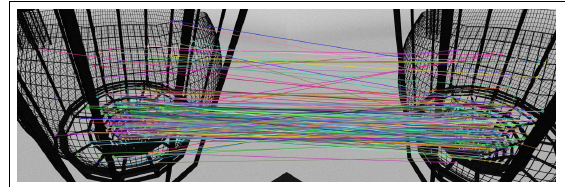
Figure 5. Matched points in both right and left image.